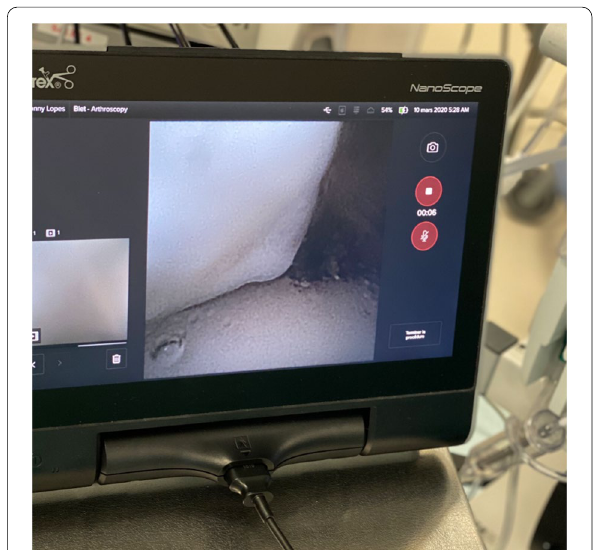
Fig. 3 NanoScopeTM 13-inch handheld console